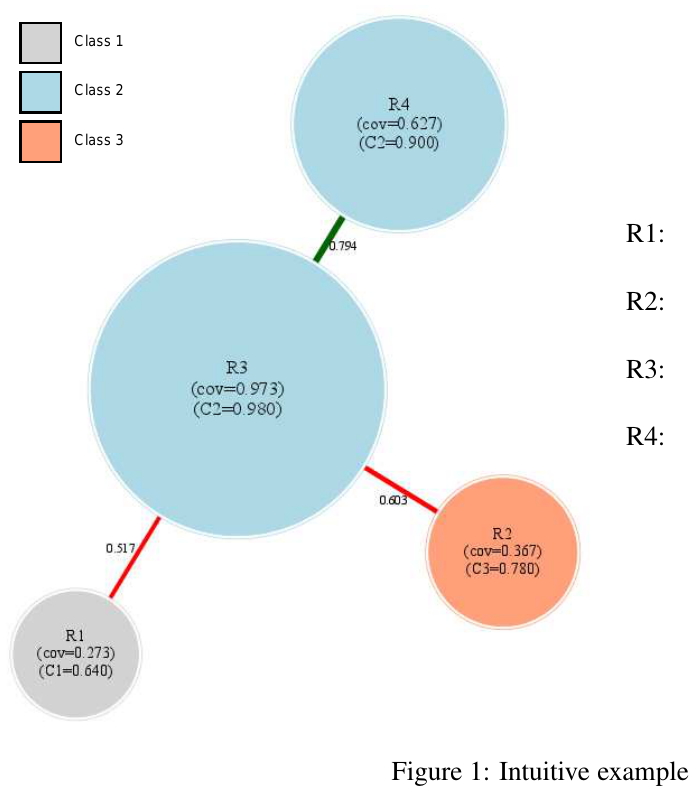
Figure 1: Intuitive example of